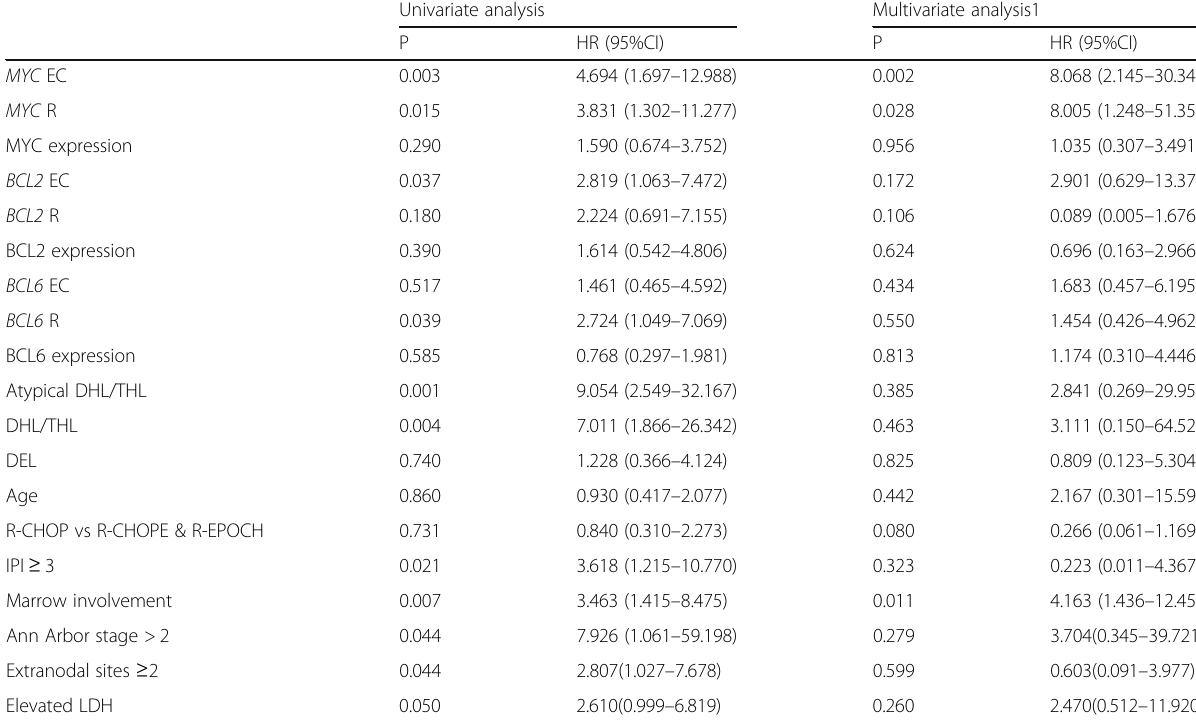
Table 3 Prognostic factors of OS of patients with DLBCL Univariate analysis Multivariate